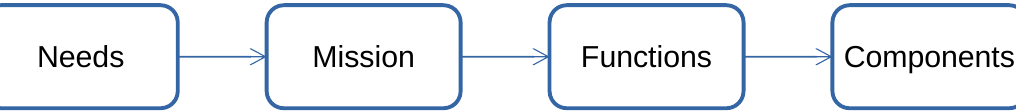
Figure 1. The system engineering flow from the needs of the final user to the concrete realization of the robot system as an aggregate of